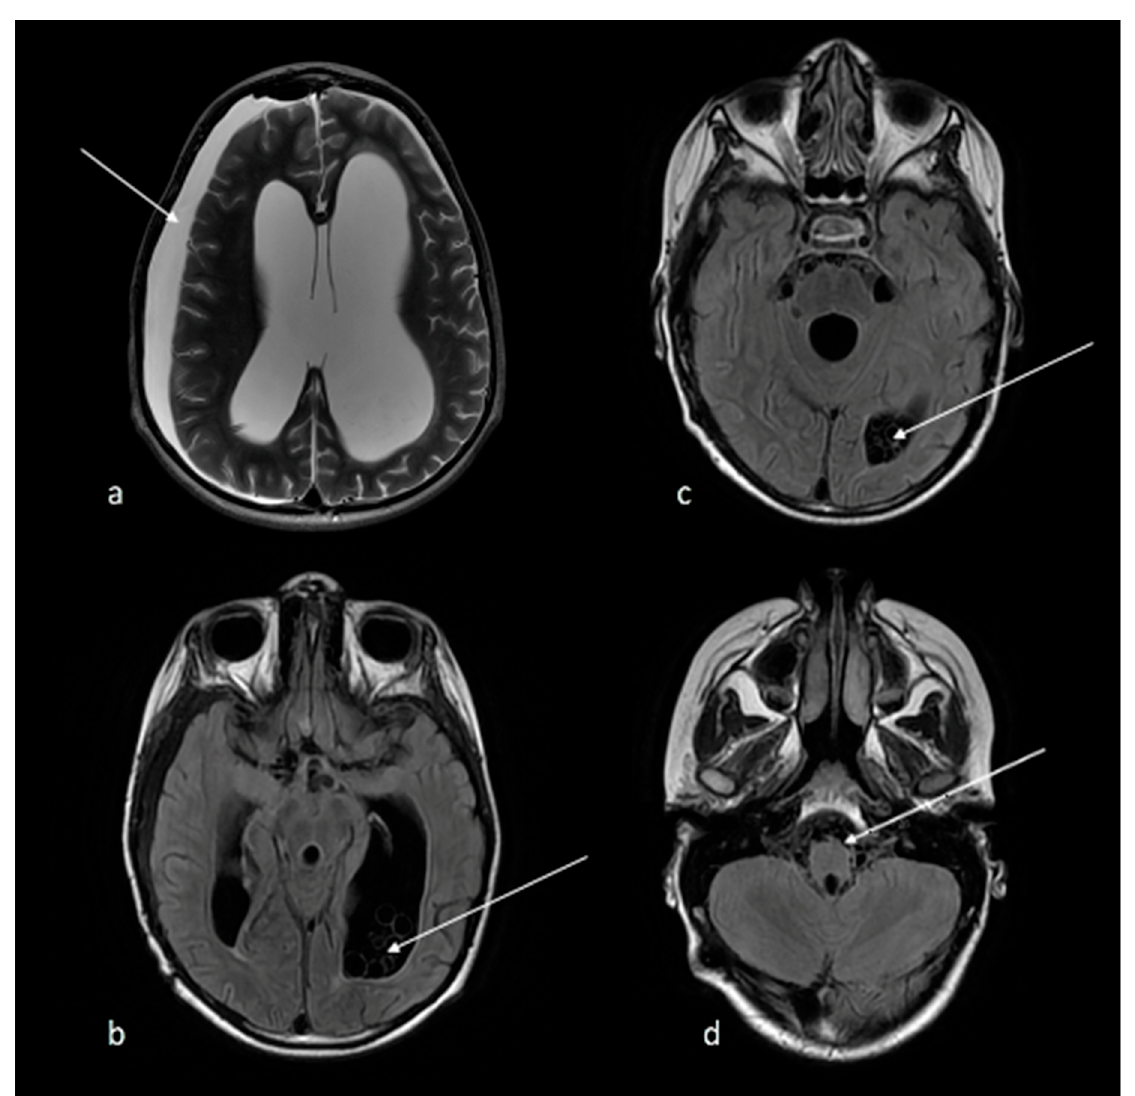
Figure 4. ( a ) T2 axial MRI brain demonstrates a right subdural collection (arrow) and further improve- ment in the hydrocephalus. ( b – d ) FLAIR axial MRI brain shows improvement in number and size